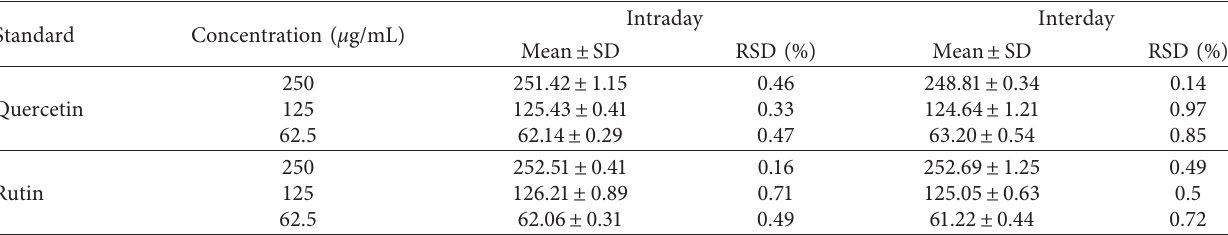
Table 5: Analytical results of intraday and interday variability.